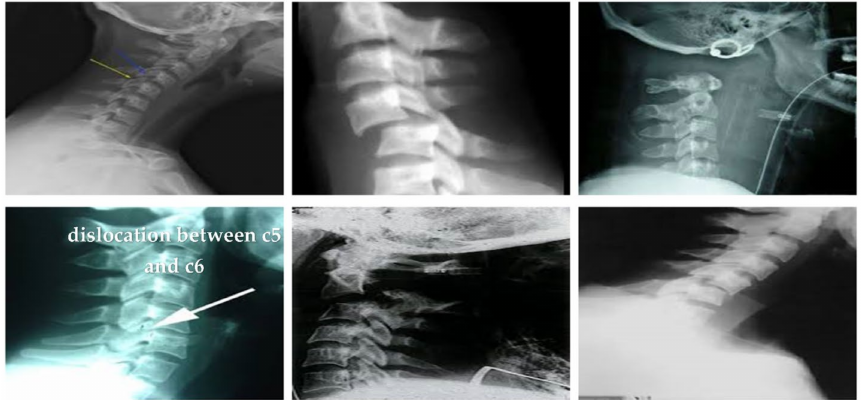
Figure 6. Samples from the first group (CS dislocation images).